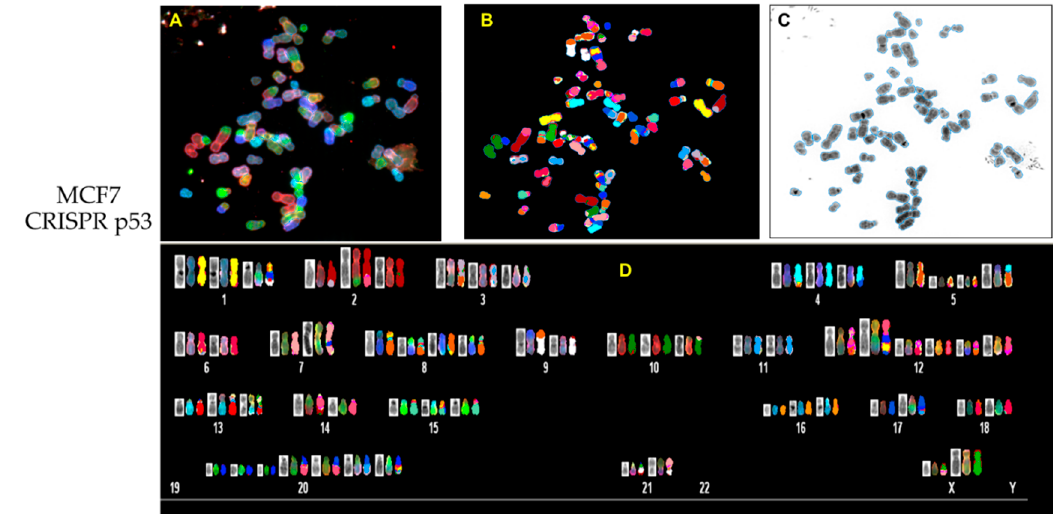
Figure 5. Spectral karyotyping (SKY) of representative metaphase from MCF7 wt and CRISPR p53 deleted cell lines. SKY was performed as described (Materials and Methods). ( A ) Metaphase spread: raw image; ( B ) metaphase spread: spectral image; ( C ) metaphase: inverted DAPI image, ( D ) classified spectral karyotype of the identical metaphase. SKY was performed in three independent experiments as described in Materials and methods. A minimum of 20 metaphases was analyzed per experiment. Upper panel: MCF7 wt; lower panel: MCF7 p53 deleted.